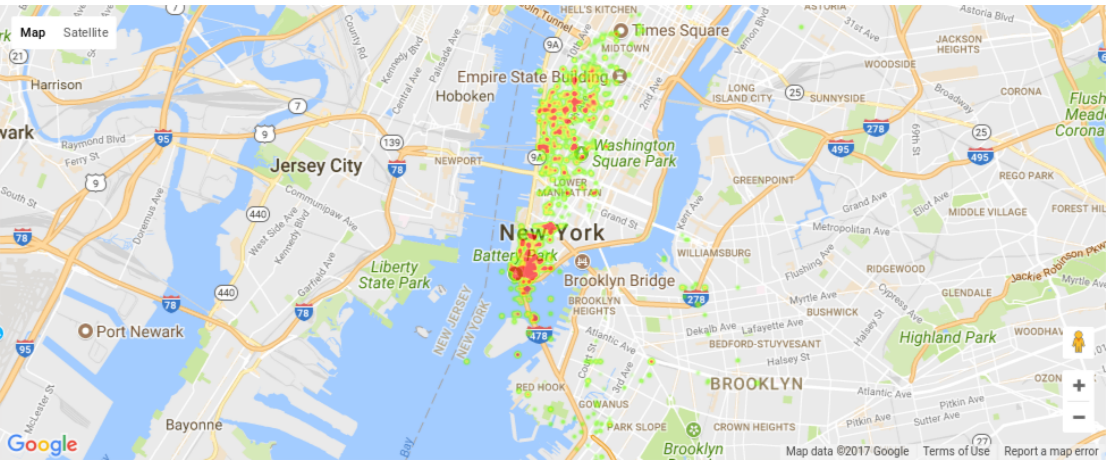
Figure 9. Priority distribution in Weeks 0 and 1.